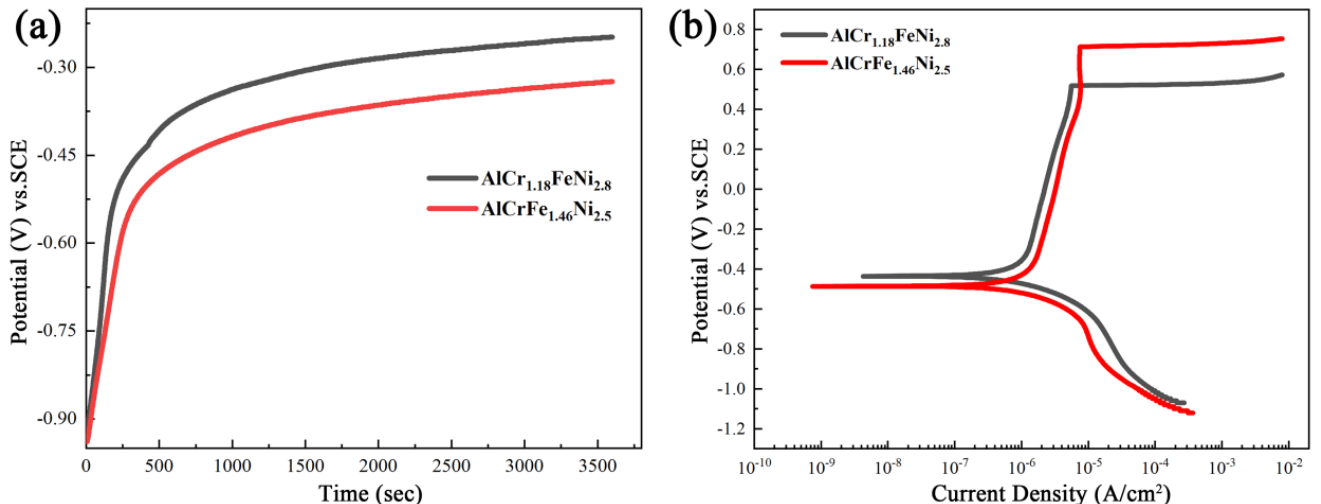
Figure 7. ( a ) and ( b ) Open circuit potential and potentiodynamic polarization curves of the